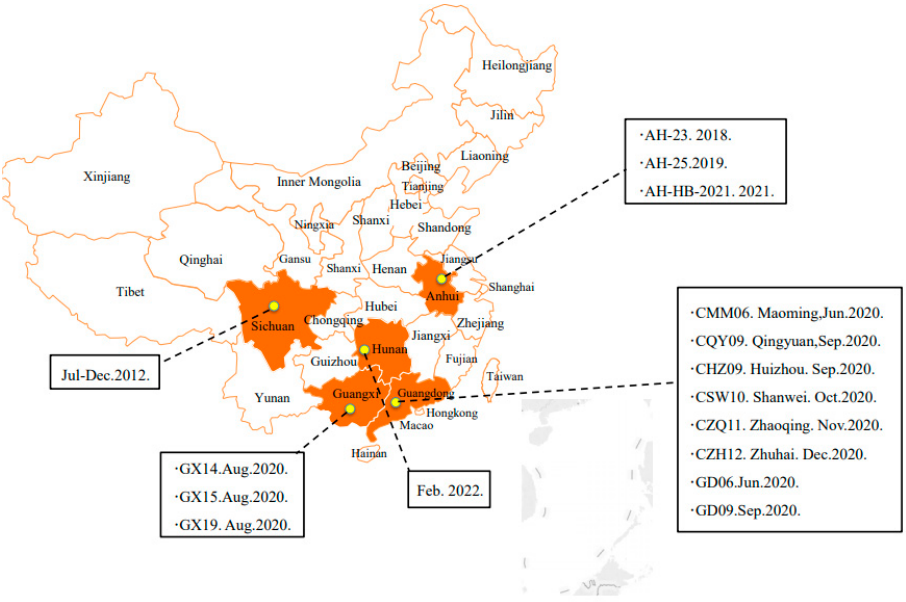
Figure 1. Geographic distribution of pigs with porcine circovirus-like virus in China. Provinces where the porcine circovirus-like virus has occurred are shown in orange, with detailed information, such as time, address, and virus name.